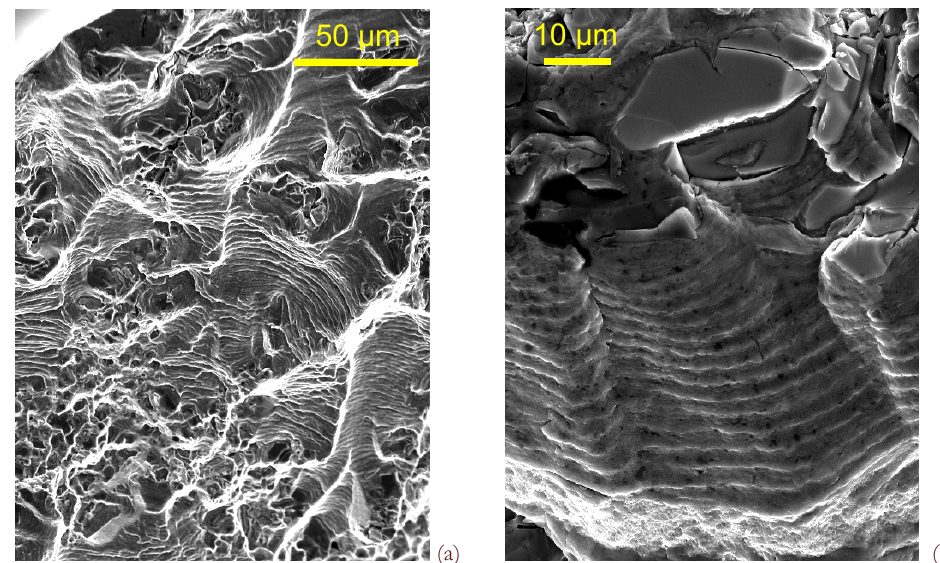
Figura 2: Striature in una lega di alluminio W319-T7 (EN AC-AlSi7Cu3Mg -T7) per fonderia. R = -1; (a): σ max = 140 MPa, T = 150 °C; (b): σ max = 100 MPa, T = 250 °C [3]. Figure 2: Crack Propagation striations in a W319 – T7 (EN AC-AlSi7Cu3Mg -T7) cast aluminum alloy. R = -1; (a): σ max = 140 MPa, T = 150 °C; (b): σ max = 100 MPa, T = 250 °C